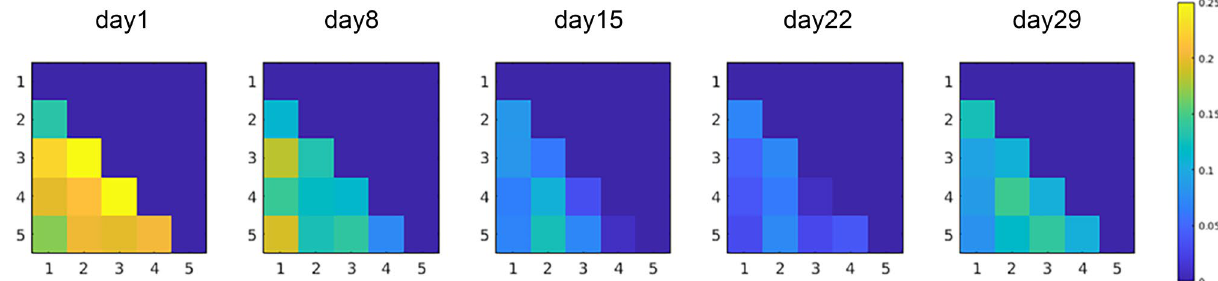
Figure 3. Difference in digit coordination patterns; combination of digits used in the reproduction task vs. the typical coordination pattern of the ball-rotation movement across measurement days. 1 = thumb, 2 = index finger, 3 = middle finger, 4 = ring finger, 5 = little finger. Zero indicates a coordination pattern that is identical to the typical coordination pattern of the ball-rotation